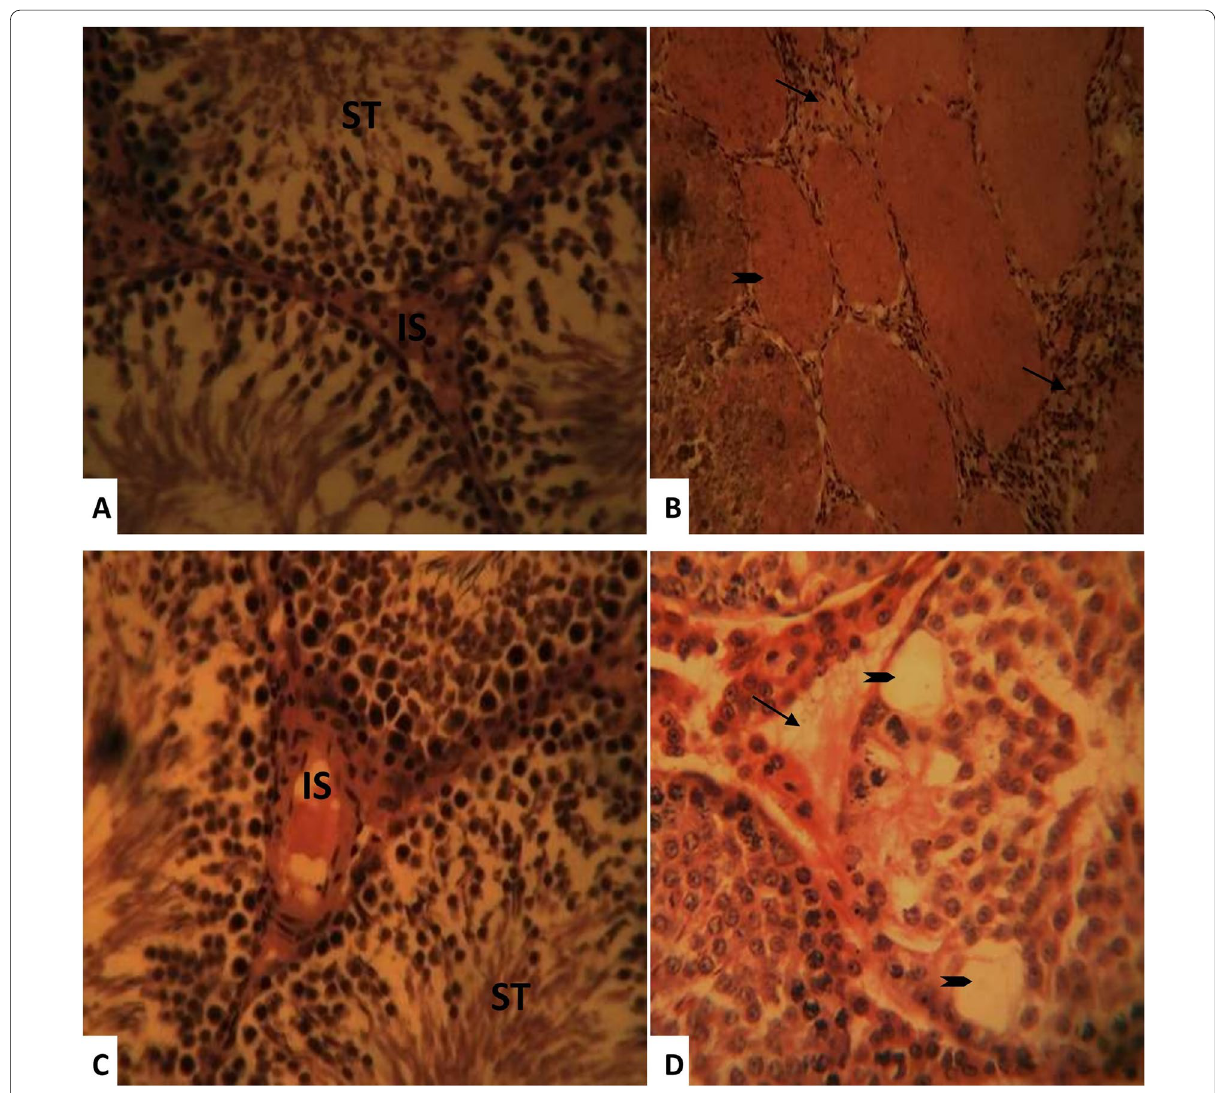
Fig. 2 Photomicrograph of the testis from Group A (control) rats showing normal seminiferous tubules (ST) and interstitial space (IS). Group B (3 mg/kg CdCl 2 ) rats showing severe necrosis of seminiferous tubules (arrowheads) and interstitial inflammation (thin arrows); Group C (500 mg/ kg TVE) rats showing normal seminiferous tubules (ST) and interstitial space (IS) and Group D (3 mg/kg CdCl 2 preserved testicular histoarchitecture with mild vacuolation and necrosis of seminiferous tubules (arrowheads) and interstitial oedema (thin arrows). H & E, 400